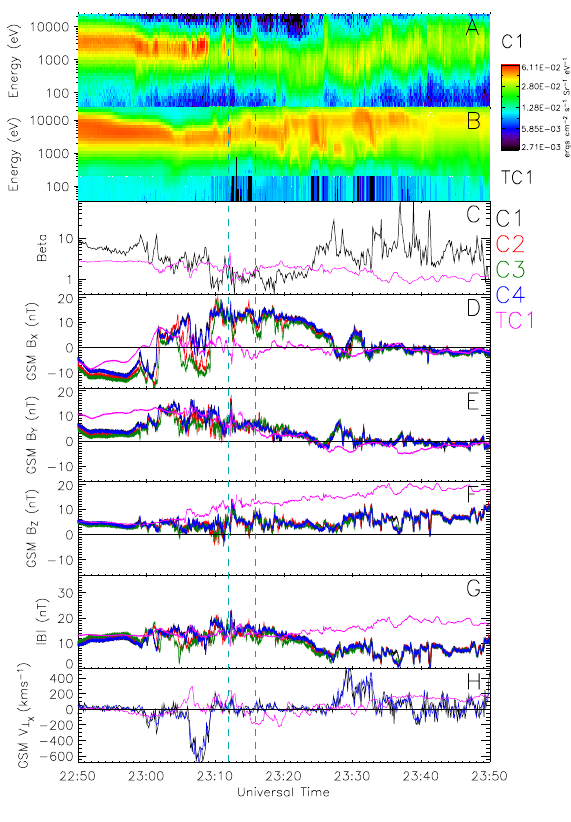
Fig. 1. Overview of the event. Panel (A) is a PEACE electron spectrogram from Cluster 1, Panel (B) the equivalent spectrogram from Double Star TC-1. Panel (C) is the plasma beta for C1 (black) and TC-1 (magenta), calculated from CIS-CODIF and HIA, respec- tively, and FGM. Panels (D) , (E) , (F) and (G) show the GSM X, Y and Z components and magnitude of the magnetic field, respec- tively, for all four Cluster spacecraft (C1 – black, C2 – red, C3 – green, C4 – blue) and TC-1 (magenta), as measured by the FGM instruments. Panel (H) shows GSM v ⊥ x , the velocity of magnetic flux transport, as measured by CIS-CODIF (C1, black and C4, blue) and HIA (TC-1, magenta). The TC-1 velocity is multiplied by 2, for clarity. The two vertical dashed lines mark the times of spacecraft encounters with Signatures 1 & 2, and Signature 3,